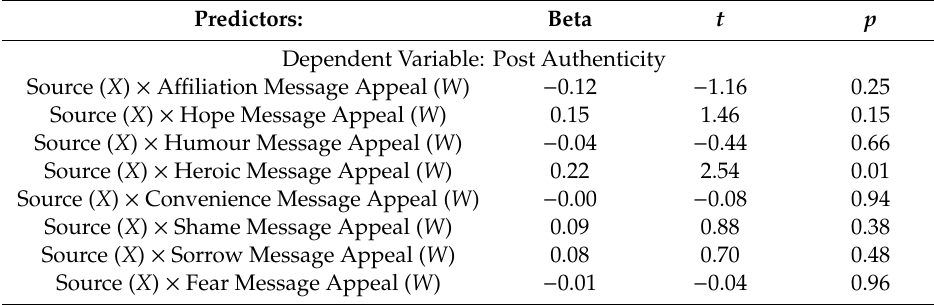
Table 4. Regression results (Source × Message Appeal on Post